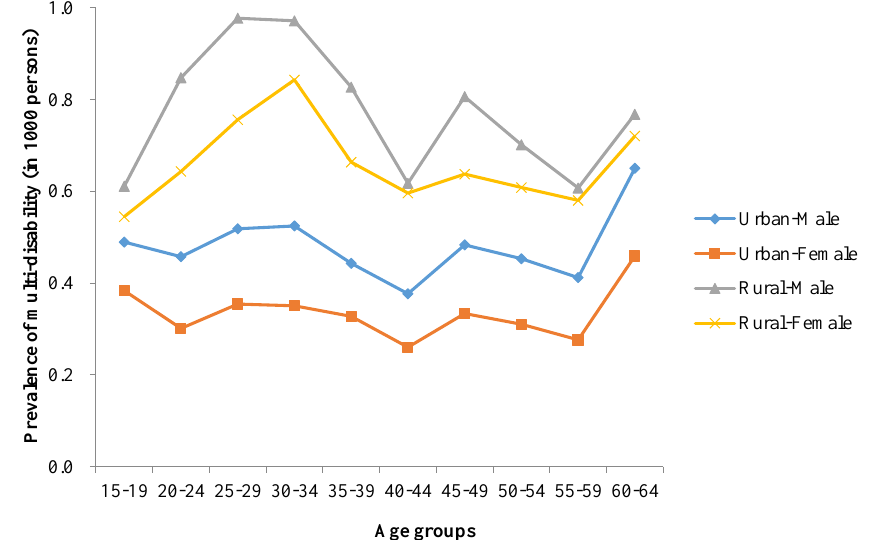
Figure 2. 2006 age standardized prevalence of multi-disability in Chinese population aged 15–64.